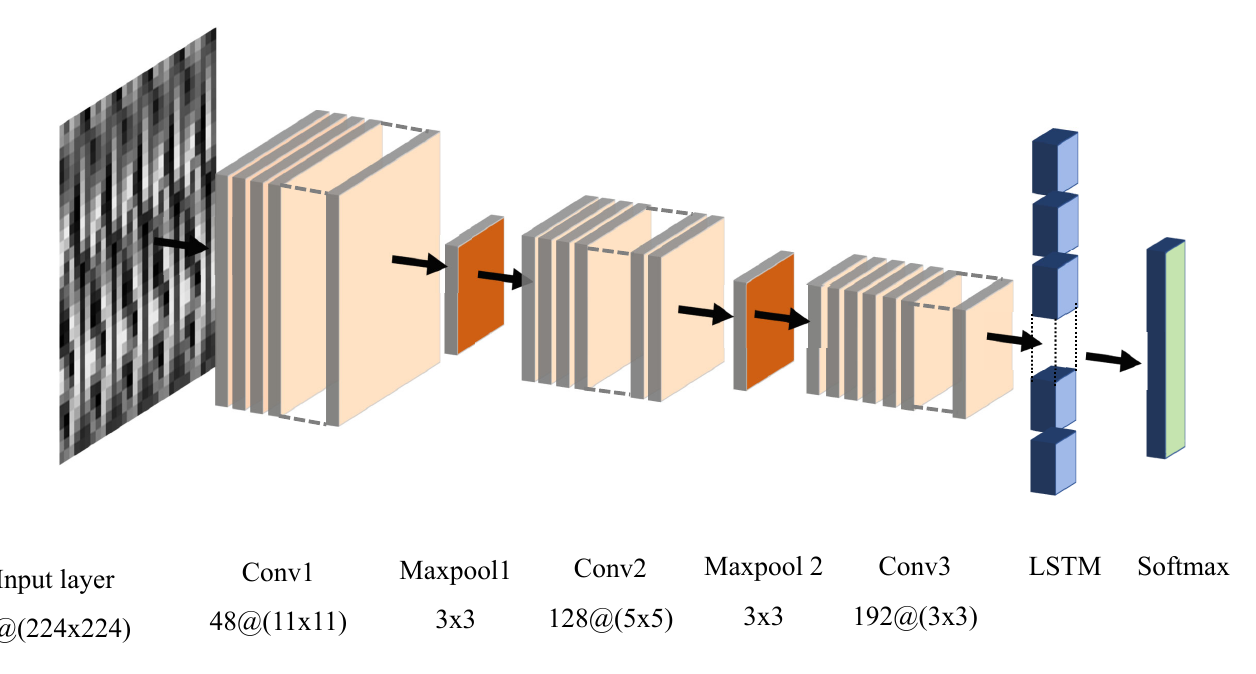
Figure 11. The structure of CNN-LSTM. Table 3. Parameters of each layer of CNN